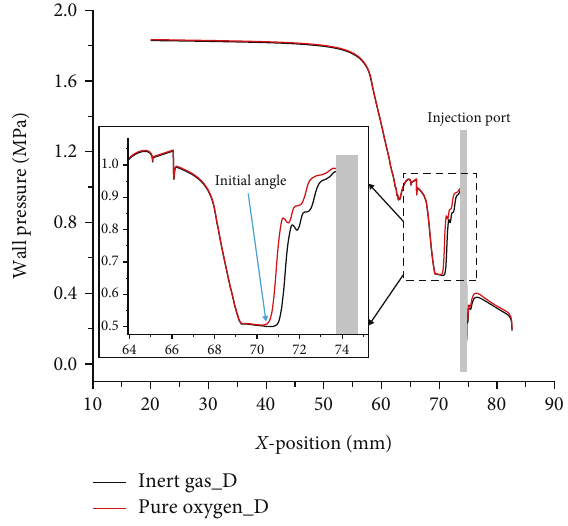
Figure 17: Pressure of upper wall (injected in